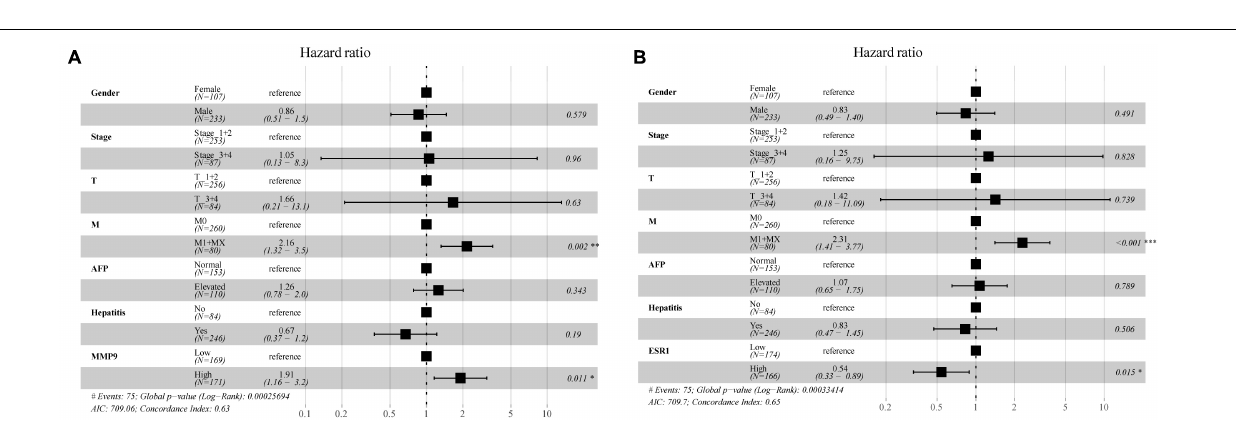
FIGURE 7 | Correlations of the six characteristic immune-related genes (IRGs) with clinical stage. (A–F) The correlation between six characteristics IRGs and clinical stage were analyzed, respectively.